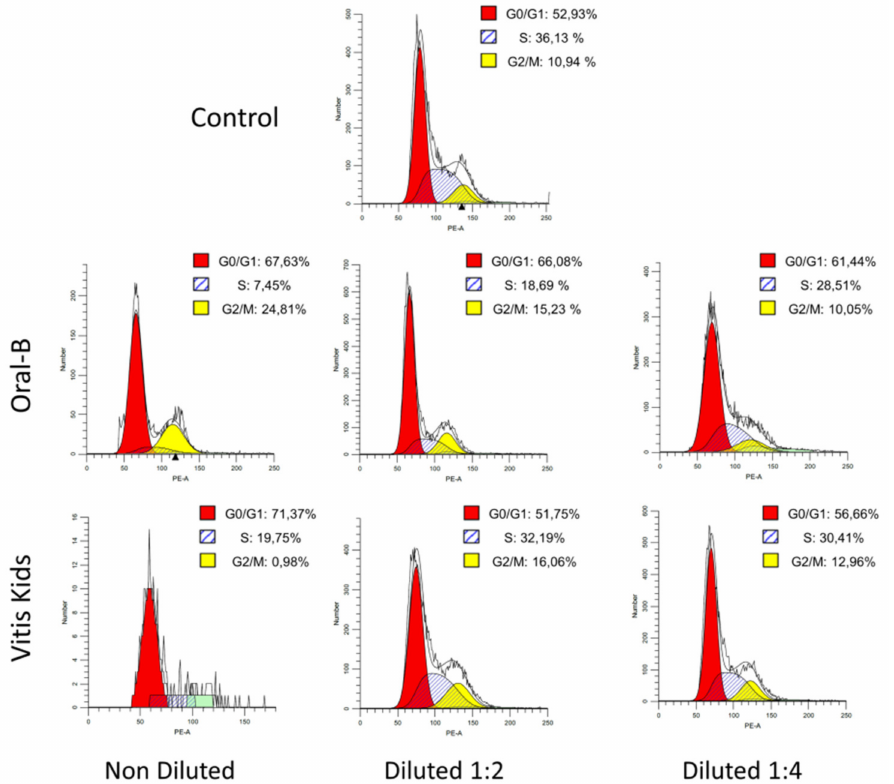
Figure 2. Cell cycle analysis of hGFs after exposure to different children’s toothpaste